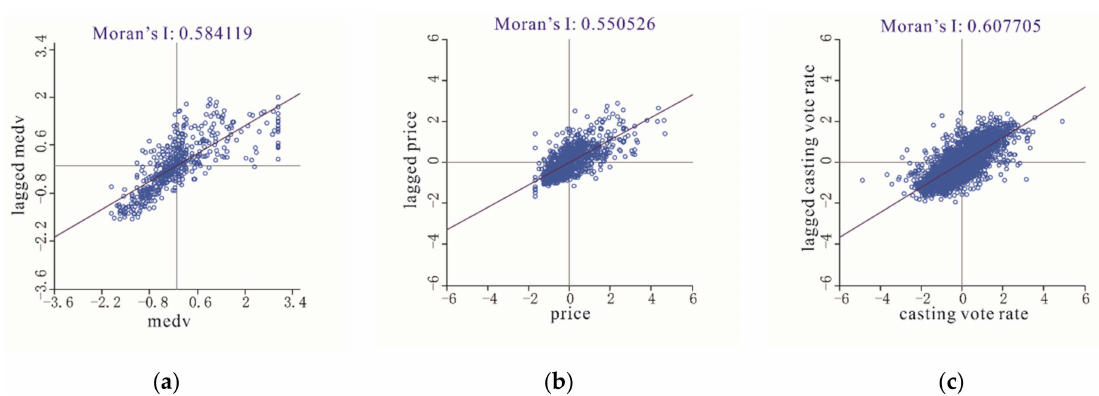
Figure 4. Moran’s I scatter diagram of the dependent variables of these three datasets: ( a ) Boston housing dataset; ( b ) real estate transactions dataset; ( c ) election